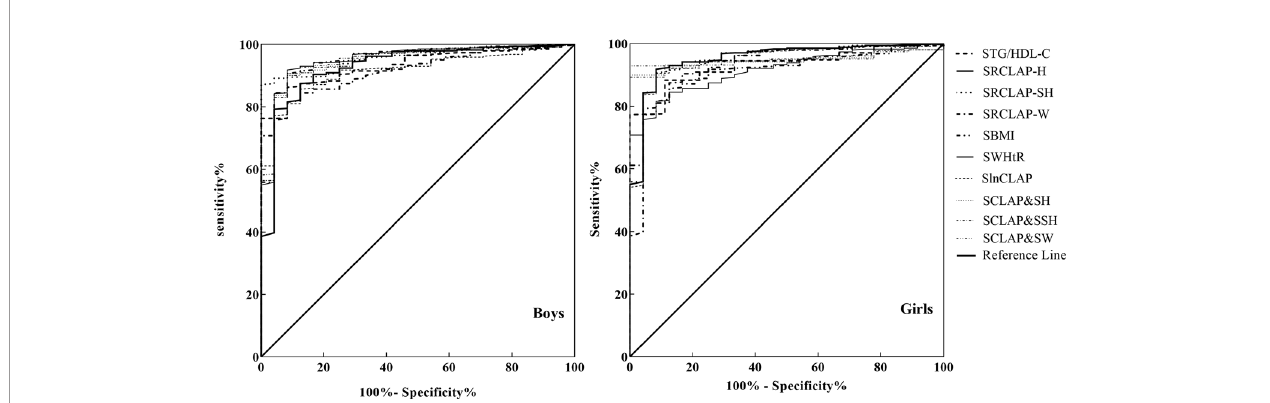
FIGURE 1 | ROC curves of SBMI, SWHtR STg/HDL-C, SlnCLAP SRCLAP-H, SRCLAP-SH, SRCLAP-W, SlnCLAP combining SH, SlnCLAP combining SSH, SlnCLAP combining SW to predict MS among boys and girls. SBMI, standardized body mass index; SWHtR, waist-height ratio; STg/HDL-C, triglycerides-to-HDL-C ratio; SlnCLAP, logarithmic children ’ s lipid accumulation product; SRCLAP-H, relative children ’ s lipid accumulation product per height; SRCLAP-SH, relative children ’ s lipid accumulation product per sitting height; SRCLAP-W, relative children ’ s lipid accumulation product per weight by sex and age using the z-score